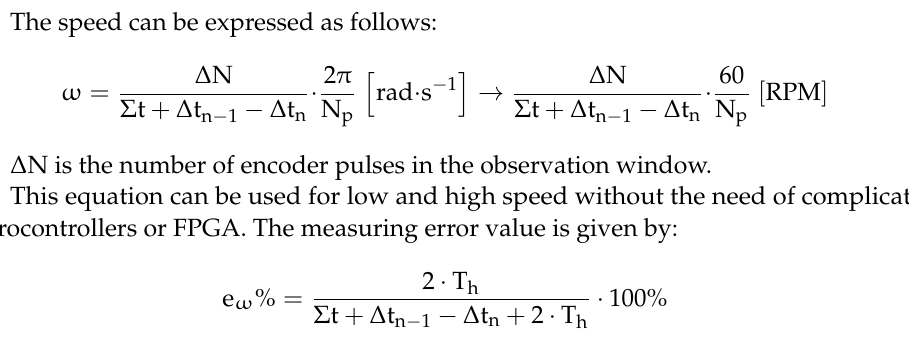
Figure 2. Error compensation using an observation window.